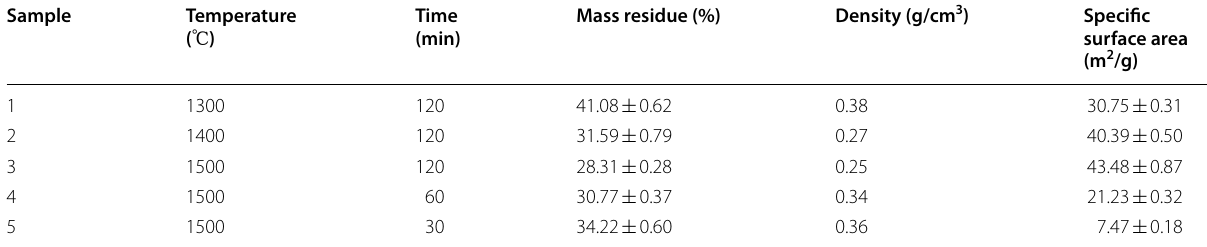
Table 1 The mass residue, density and specific surface area of the R–SiC prepared at different pyrolysis conditions